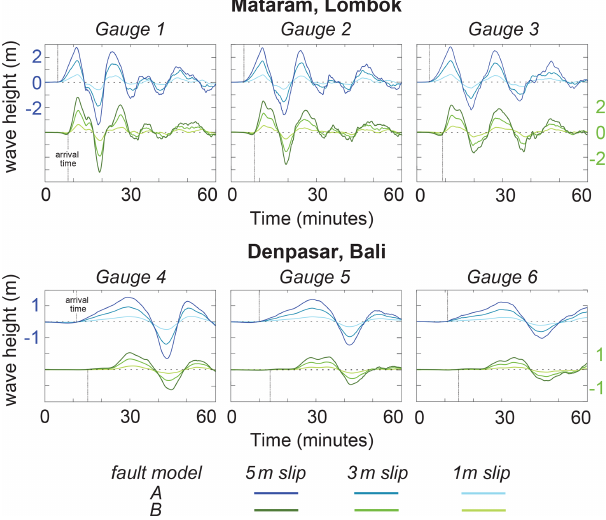
Figure 11. Sea surface elevation generated by fault models A and B recorded at virtual tide gauges located along the 10m water depth contours offshore Mataram (gauges 1 to 3) and Denpasar (gauges 4 to 6). The records for fault models A and B in Mataram are sim- ilar in terms of wave heights and arrival times. In Denpasar, the models have similar wave patterns but the arrival times for model A are slightly earlier than in model B. After the earthquake, the first tsunami in Mataram arrives at < 9min, while in Denpasar it arrives at ∼ 12–18min for model A and ∼ 23–27min for model B. The peak of the first wave is at ∼ 11min and ∼ 30min in Mataram and Denpasar, respectively.